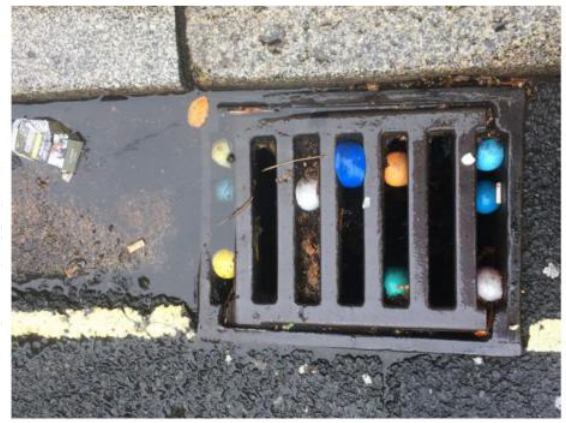
Figure 14. Plastic balls in Liverpool